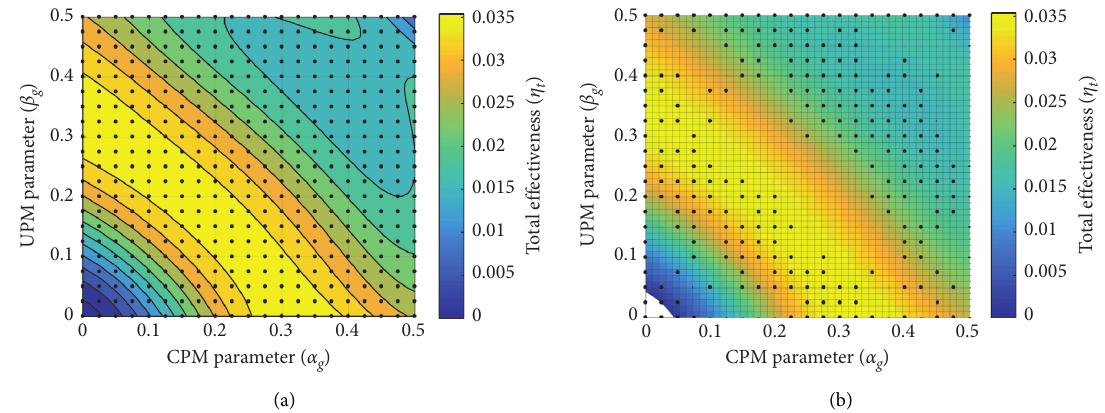
Figure 7: Investigating the effect of gatherers’ CPM and UPM on the HGMP’s effectiveness η polynomial curve fitting and (b) polynomial curve fitting.